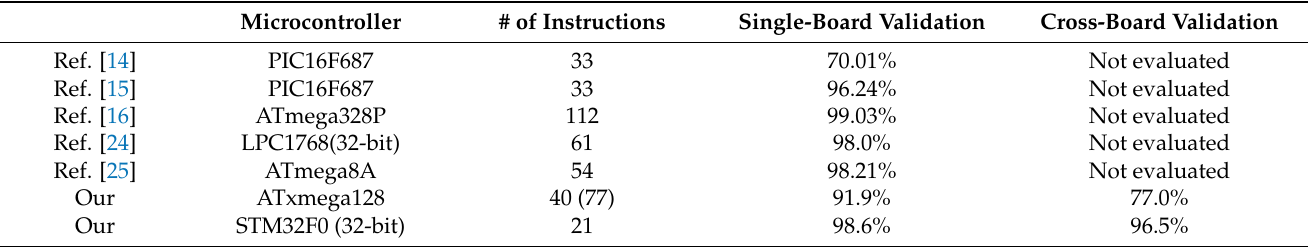
Table 4. The comparison between our side-channel-based disassembler and existing disassemblers. Microcontroller # of